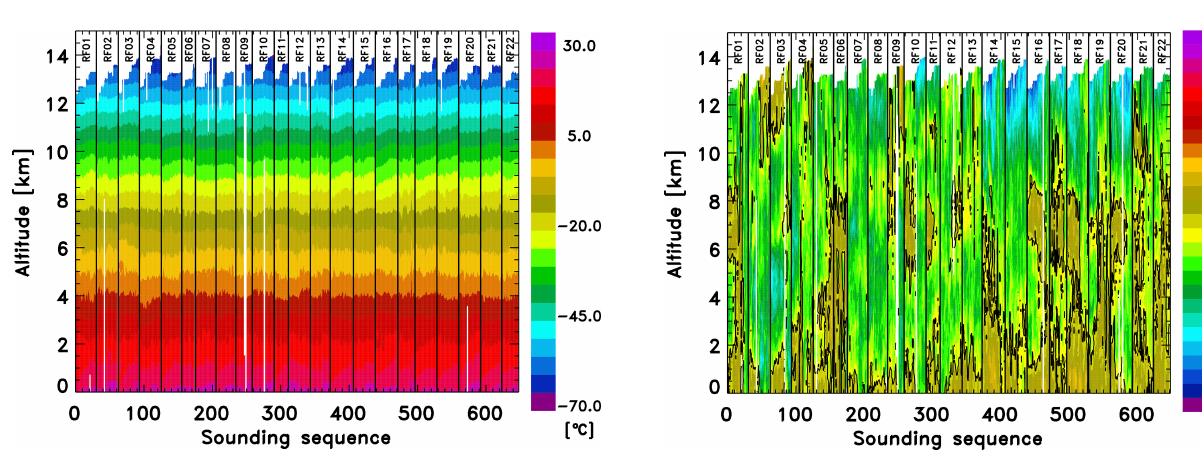
Figure 11. Color contours for all zonal wind speed measurements. The solid contour indicates the zero zonal wind. Vertical lines sep- arate the research flights, which are indicated in each